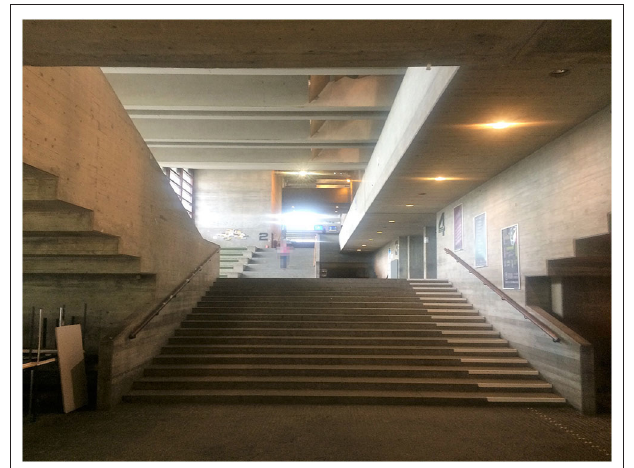
FIGURE 6 | Wide staircases are inviting to use them. Students use them automatically without thinking about it (Photo: U2 S31).